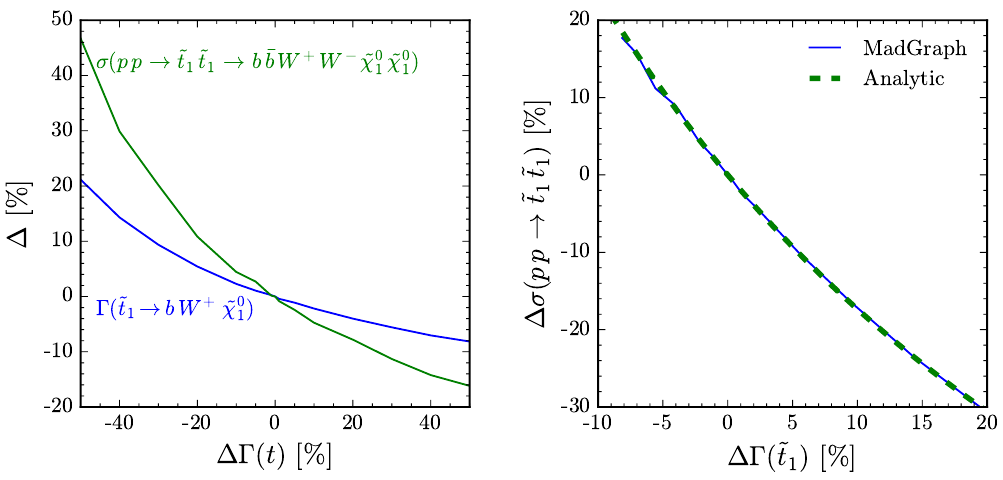
Figure 5 . The left panel shows the impact of the change in top width on the width of the stop (blue) and on the stop pair production cross section (green). The right panel shows the impact of the change in the stop width on the stop pair production cross section (blue solid line); the corresponding analytic curve (green dashed line) is given in eq. (2.7).